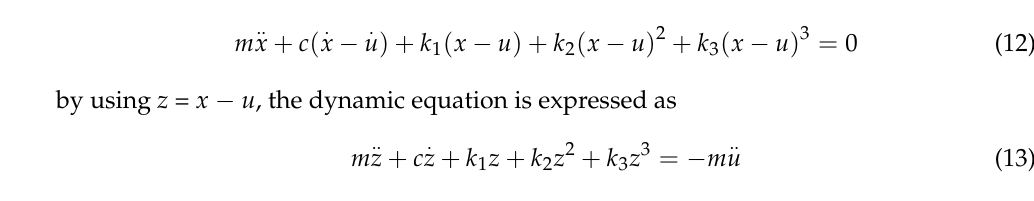
Figure 8. Passive vibration isolation model.